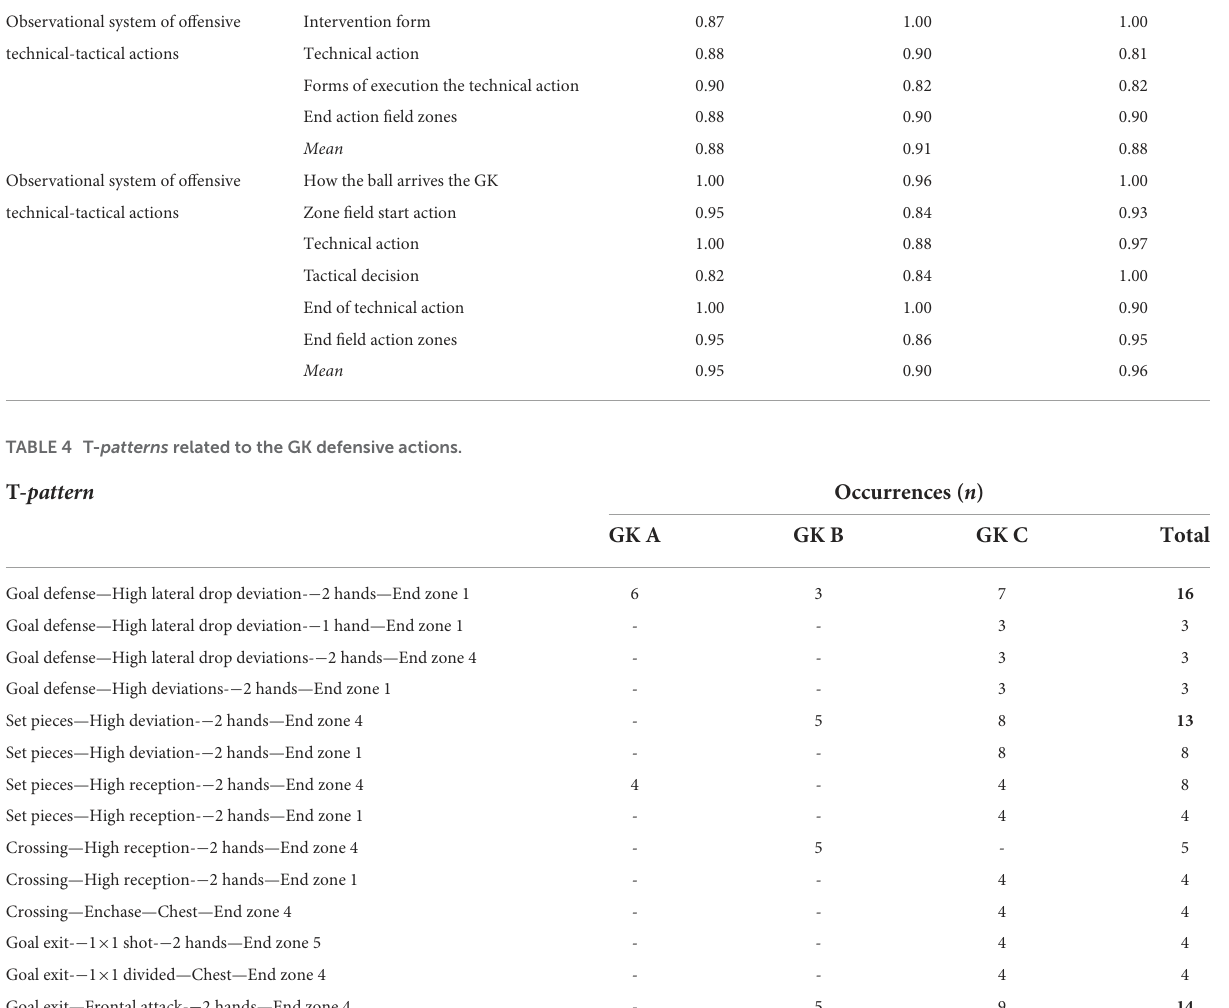
TABLE 3 Intra- and inter-observer reliability. Observation system